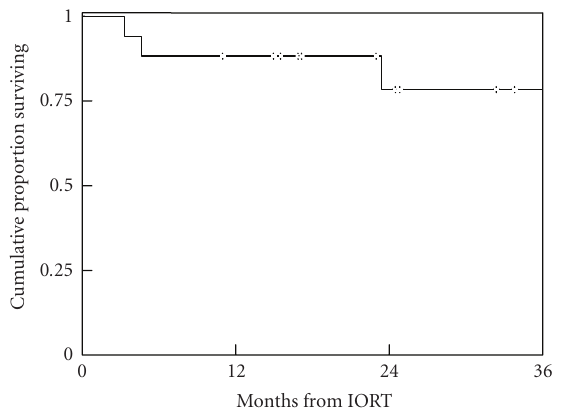
Figure 3: Locoregional control. Two of the 17 patients failed locore-